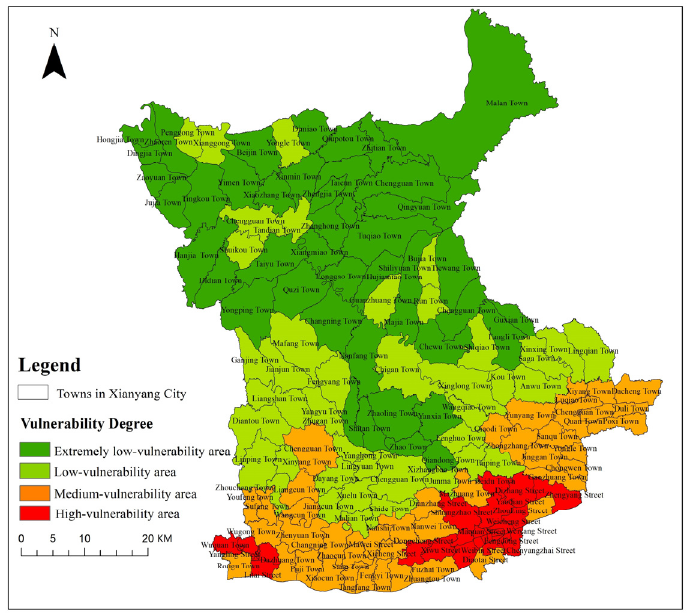
Figure 11. Landslide vulnerability assessment zoning map of Xianyang City.